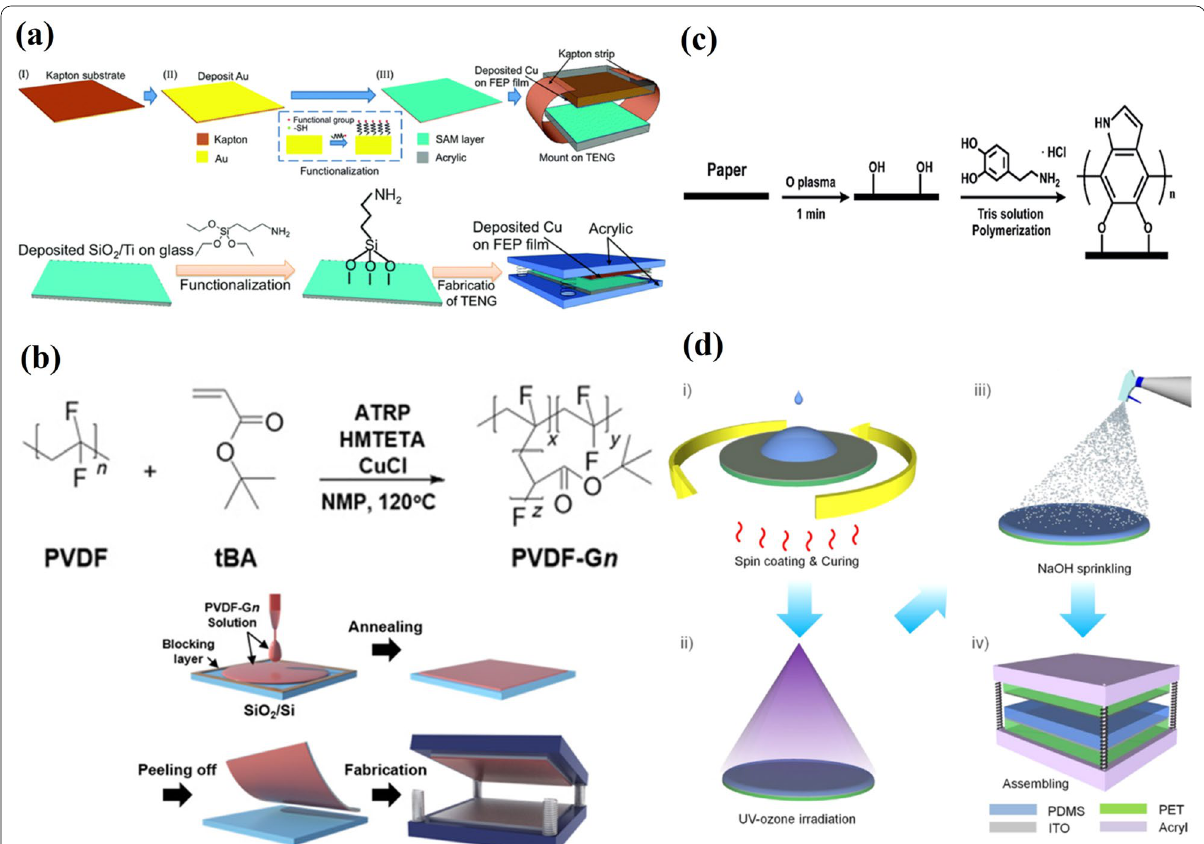
Fig. 12 Chemical functionalization of TENG surface layer. a Fabrication process of TENGs from the thiol-SAM functionalized Au films (i) and from SAM surface functionalized SiO2 (ii) (Reproduced with permission from Ref. [82]). b Synthesis of PVDF-Gn graft copolymers and schematic diagram of the fabrication process for the PVDF-Gn-based TENG (Reproduced with permission from Ref. [83]). c Schematic diagram of polydopamine modification of paper (Reproduced with permission from Ref. [84]). d Schematic illustration of surface treatment of polydimethylsiloxane (PDMS) polymer film and a TENG device (Reproduced with permission from Ref.